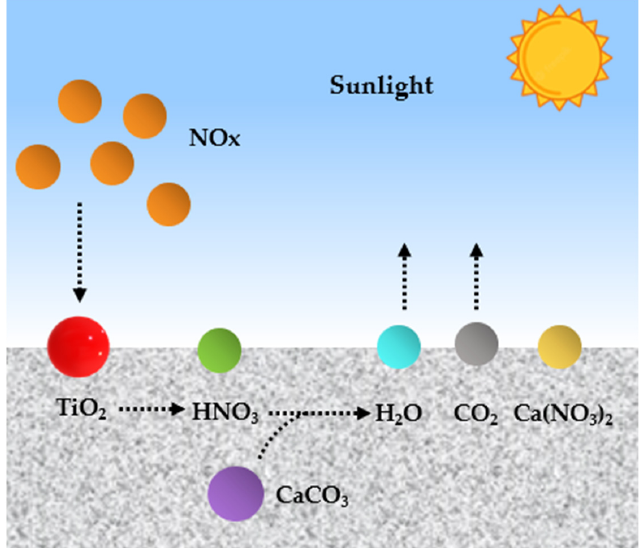
Figure 5. Oxidation of contaminants by means of cementitious materials with incorporation of TiO 2 .